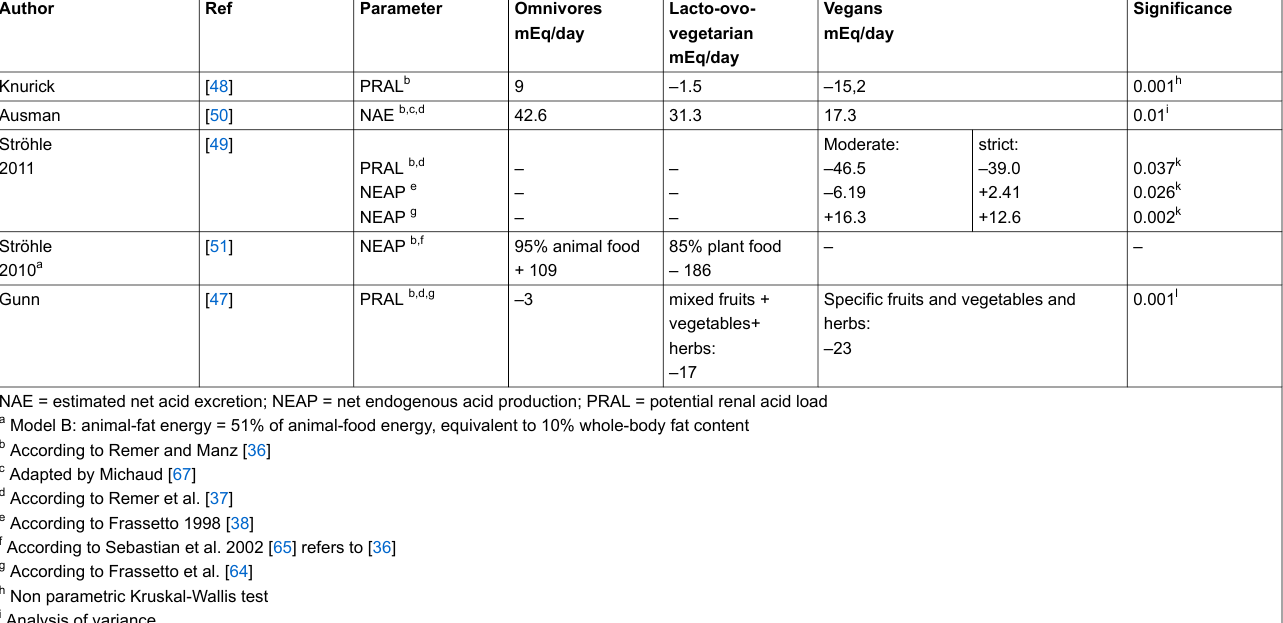
Table 2: Assessment of the nutritional acid load of vegetarian and vegan diets in comparison to omnivore diet. (Each study used different method of assessment. This explains the variability between the studies. But the relative differences between omnivores, lacto-ovo-vegetarians and vegans are consistent.)